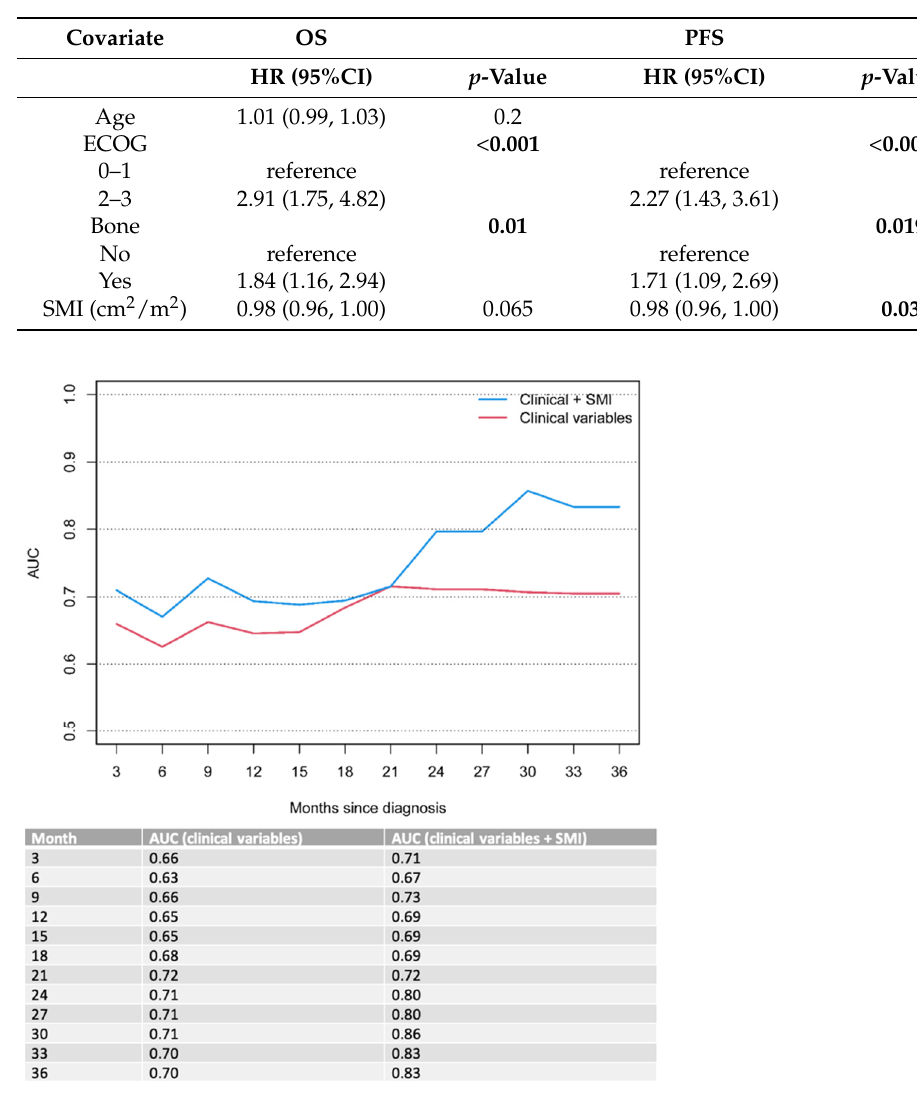
Table 4. Multivariable Cox regression analysis for OS and PFS in the overall cohort.